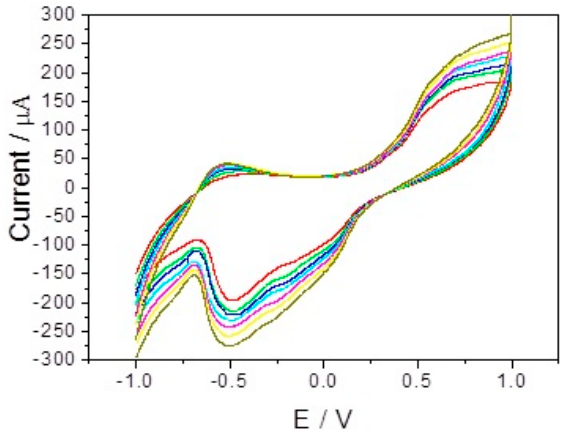
Figure 5. CVs of branch-trunk Ag hierarchical nanostructures/GCE in 0.1 M PBS (pH = 7.4) containing, 2 mM, 3 mM, 4 mM, 5 mM, 6 mM, 7 mM, 8 mM H 2 O 2 . Scan rate: 50 mVs − 1 .